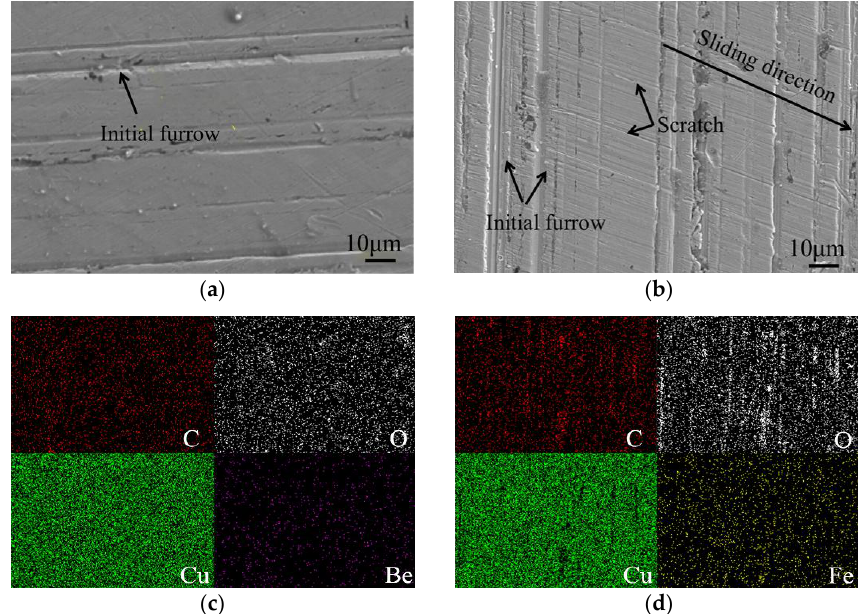
Figure 6. SEM results on the QBe2 beryllium bronze pins: ( a ) on the initial surface, ( b ) on the worn surface, ( c ) mapping scanning results on the initial surface and ( d ) mapping scanning results on the worn surface.